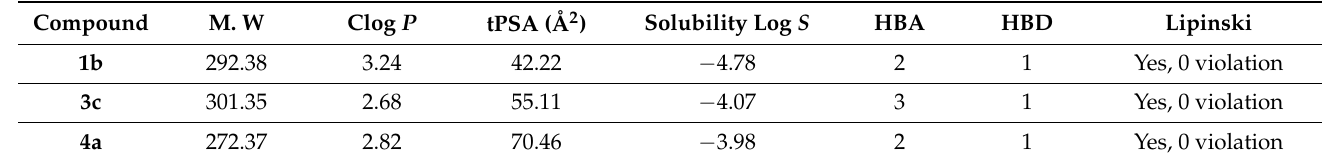
Table 7. Calculated molecular and physiochemical parameters of compound 1b , 3c , and 4a.